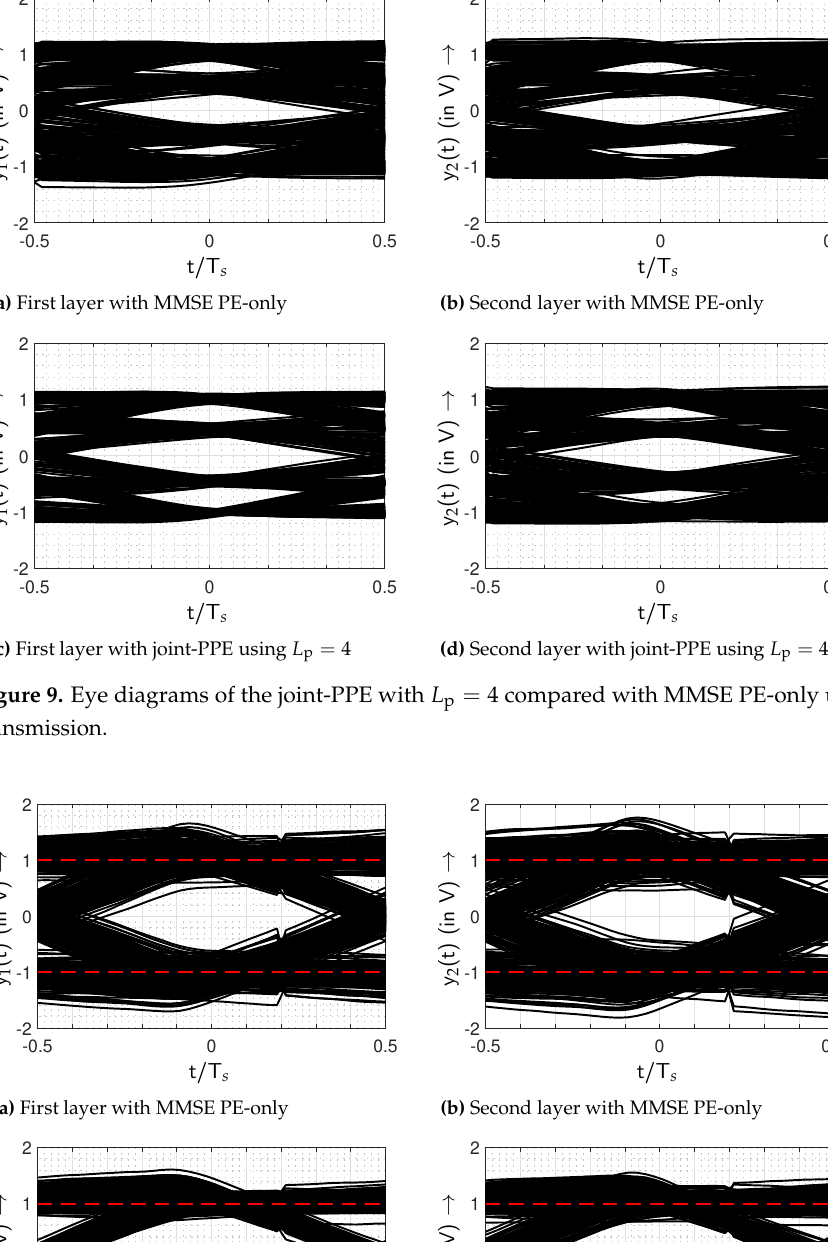
uator (VOA) is incorporated in the setup for the purpose of BER performance evaluation 175